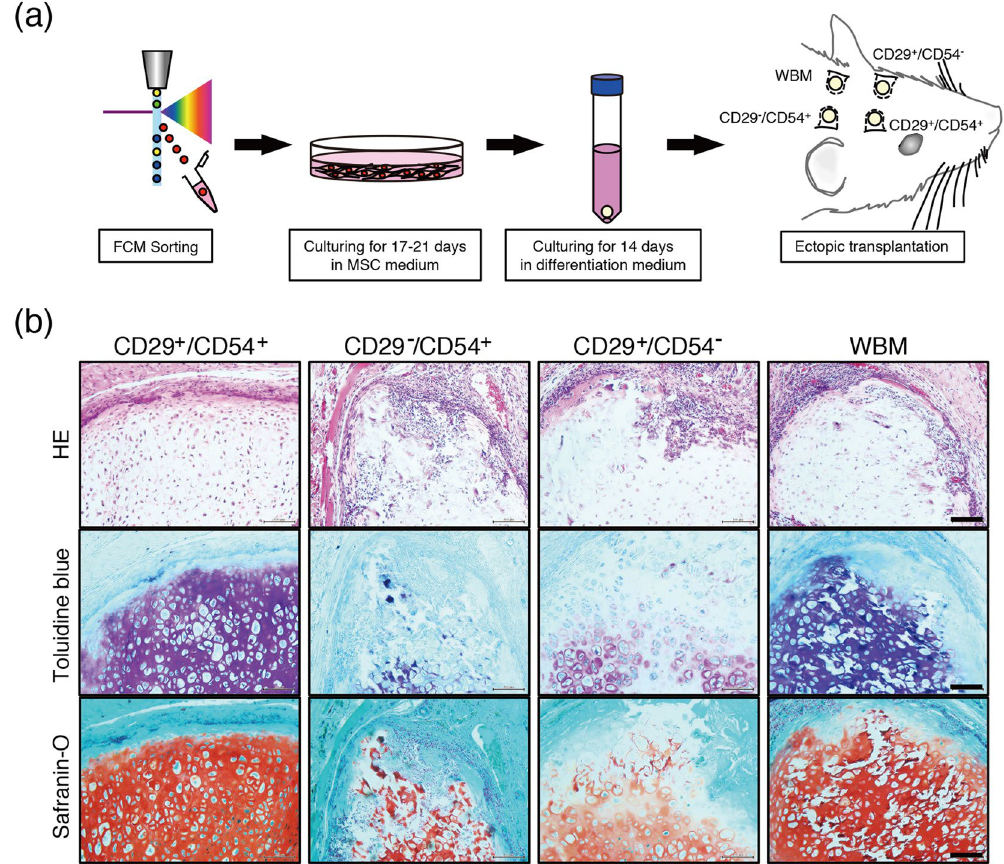
Figure 2. Transplantation of rMSC-derived chondrocytes into hypodermal tissue. ( a ) Scheme of cell isolation and transplantation procedures. ( b ) Representative histological sections of cell pellets transplanted after 2 weeks. The pellets were sectioned (5 µ m thick) and stained with haematoxylin and eosin (HE), toluidine blue, and safranin O. Scale bar, 100 µ